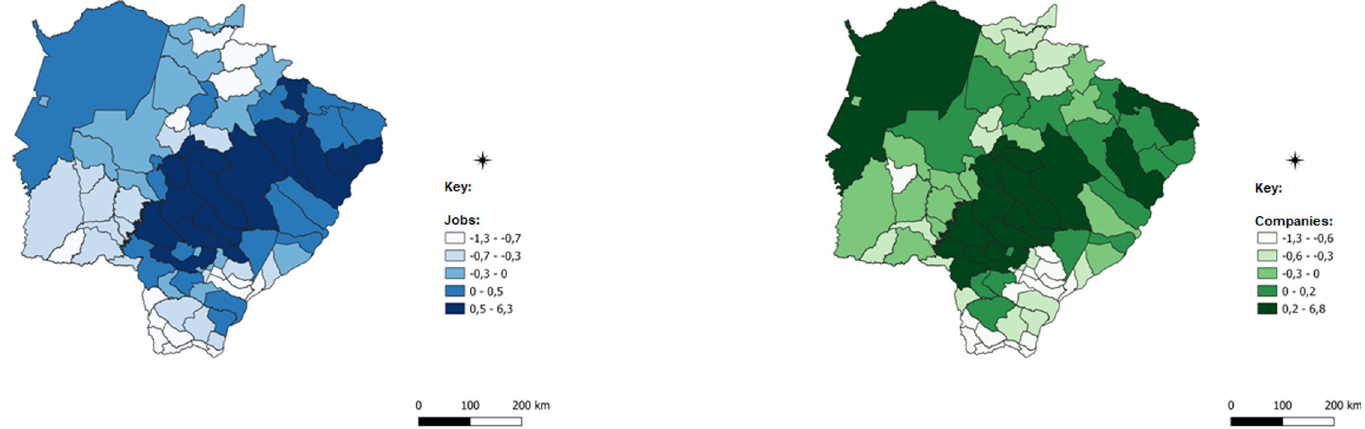
Fig 10. Spatially weighted Compound Concentration Index of farming. Caption credit: Elaborated from secondary data extracted from [26].